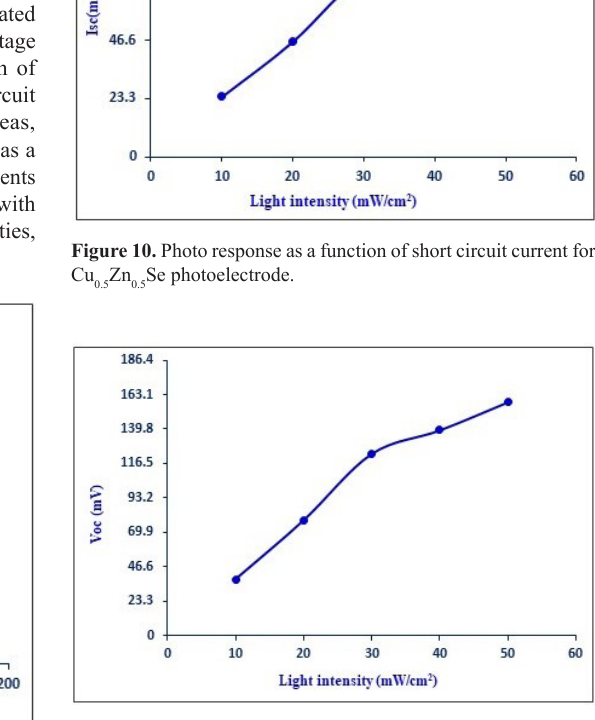
Figure 11. Photo response as a function of open circuit voltage for